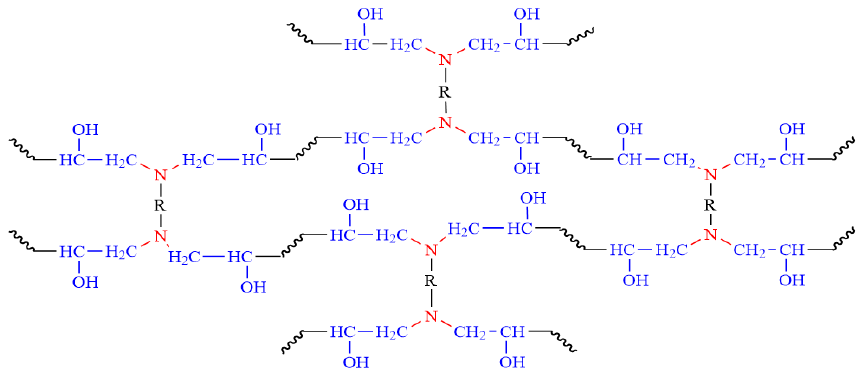
Figure 3. The curing reaction of epoxy resins with hardener.